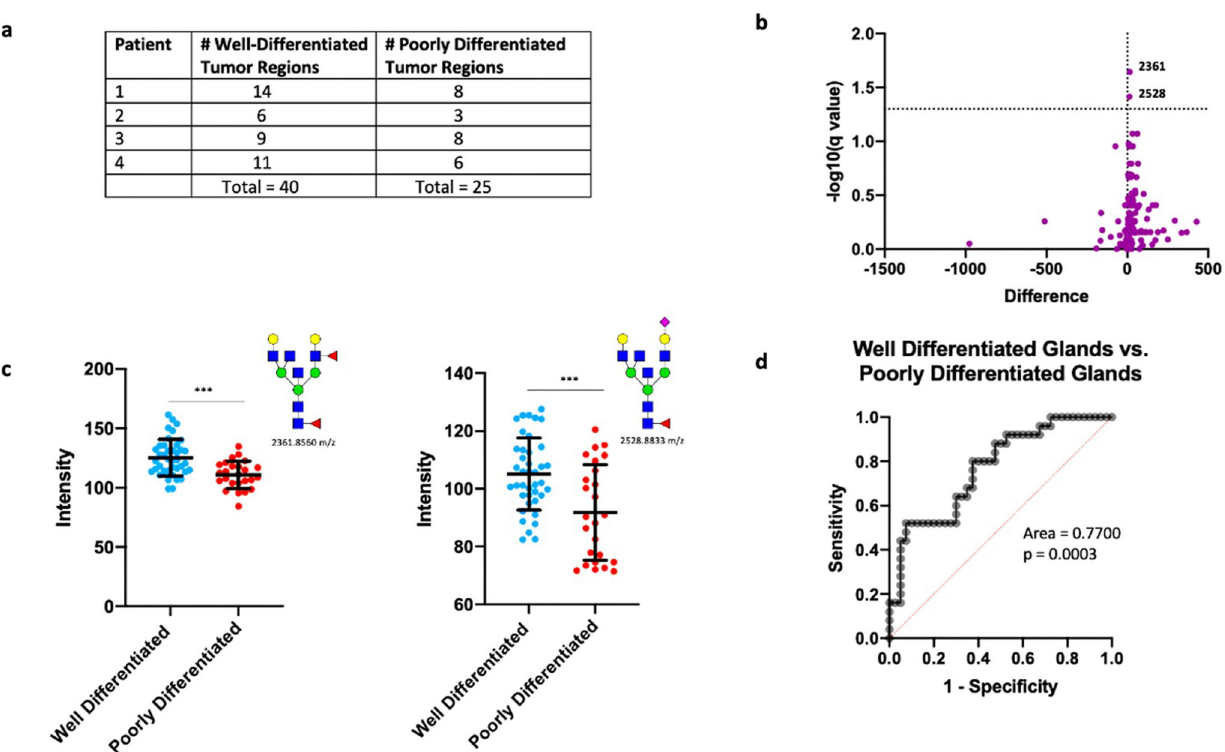
Fig. 2 N -linked glycosylation changes associated with loss of differentiation. a Table demonstrating the number of annotated well- differentiated and poorly differentiated tumor regions for each patient. b Volcano plot comparison of all glycans in annotated well- differentiated tumor regions ( n = 40) and annotated poorly differentiated tumor regions ( n = 25) with 2361.8560 m/z and 2528.8833 m/z showing statistical signi fi cance between the two groups. c Scatter plot comparison of Gal3Fuc2Man3GlcNAc6 and Gal3Fuc1Neu5Ac1- Man3GlcNAc6 between all well differentiated ( n = 40) and poorly differentiated ( n = 25) tumor regions. Statistics performed between each group by multiple, unpaired t test with p < 0.05 considered signi fi cant. The following system was used to denote signi fi cance: p < 0.05 (*), p < 0.01 (**), p < 0.0001 (***), p < 0.00001 (****). Error bars correspond to standard deviation. d Receiver operator characteristic (ROC) curve demonstrating the predictive power (AUC = 0.77, p = 0.0003) of Gal3Fuc2Man3GlcNAc6 and Gal3Fuc1Neu5Ac1Man3GlcNAc6 loss for identifying poor differentiation of ( n = 37 patients) (Fig. 3a). All hormonally-treated PCa tissues were from patients who received neoadjuvant hormonal therapy